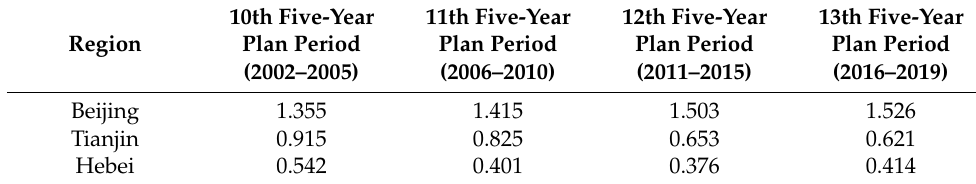
Figure 2. Changes in carbon emissions from UCL of cities in Hebei Province, during 2002–2019. Table 4. Change in the mean value of efficiency between periods.